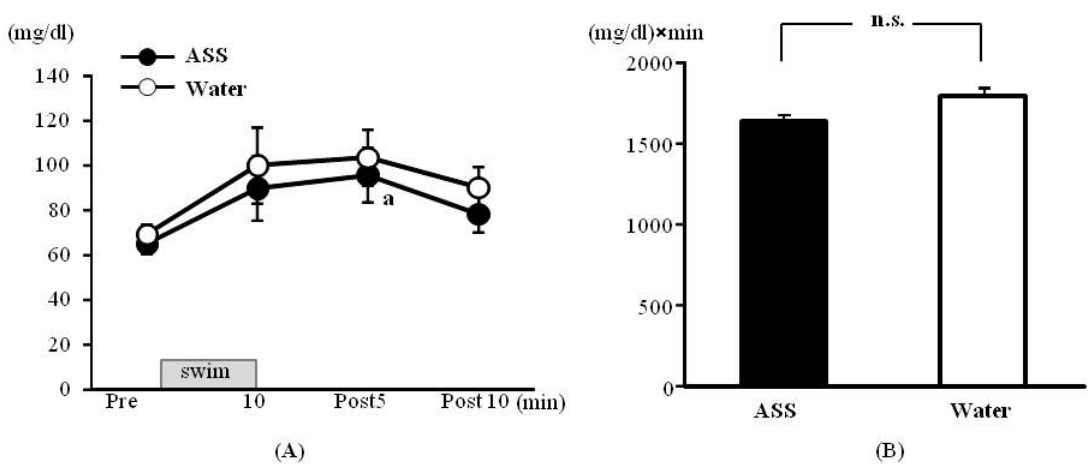
Figure 4. Changes in the blood glucose on swim exercise. ( A ) time course change, x axis: elapsed time on swimming, y axis: blood glucose concentration ( B ) area under the curve of blood lactate acid, x axis: group, y axis: total volume of blood glucose. Values are expressed as mean ± SE. a: significant difference from rest ( p < 0.05). n.s.: no significant